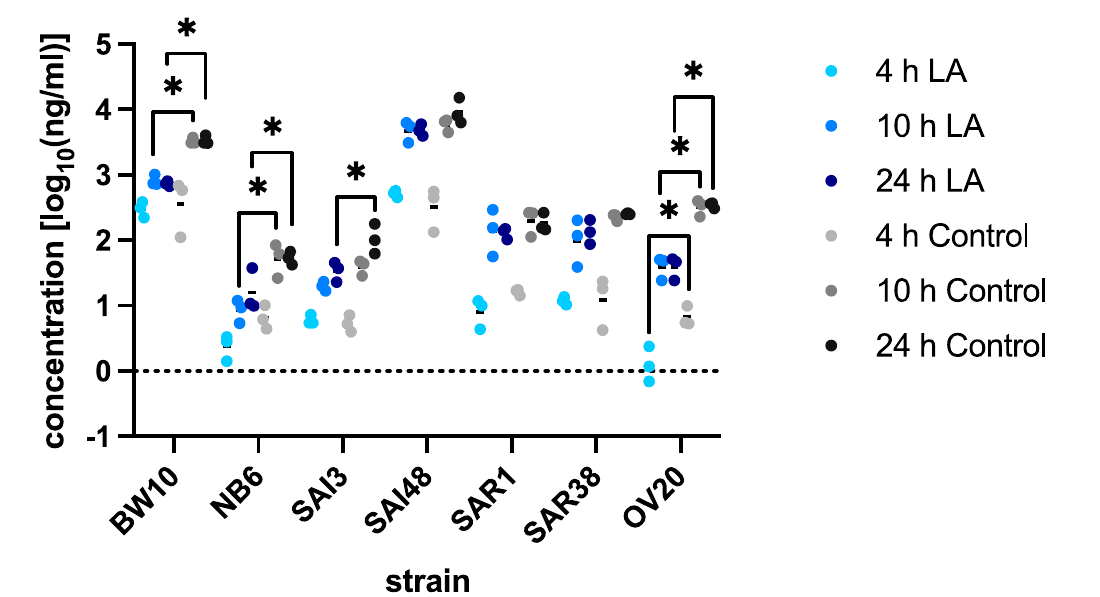
Figure 2. SEC concentration in log 10 ng/mL under lactic acid stress (pH 6.0) compared with control conditions in Staphylococcus aureus strains BW10, NB6, SAI3, SAI48, SAR1, SAR38, and OV20 in exponential (4 h), early stationary (10 h), and late stationary (24 h) phase. SEC levels under control conditions are shown in grey; pH stress levels are shown in blue. Replicates are shown as single data points; horizontal lines indicate means. Darkening fill colors indicate progressing time points. Statistically significant differences between conditions are indicated by lines with asterisks (* p < 0.05).